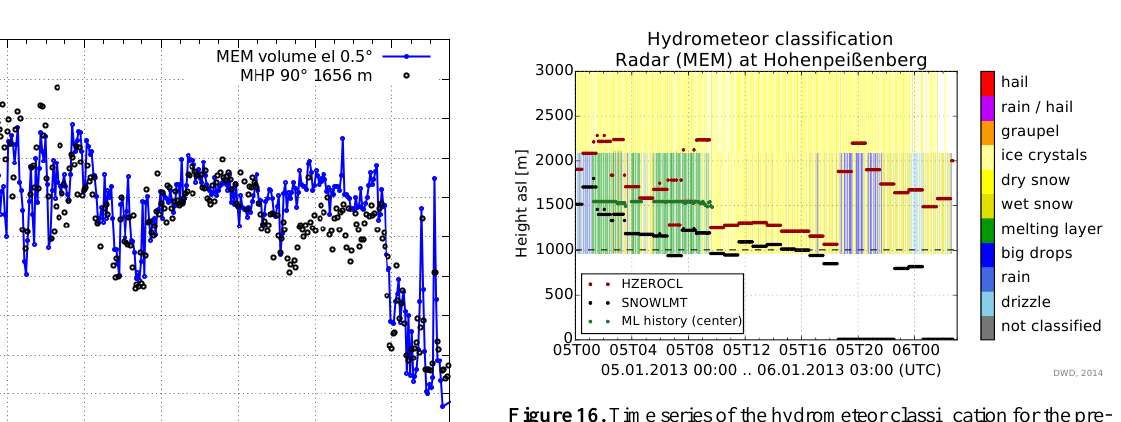
Figure 16. Time series of the hydrometeor classification for the pre- cipitation scan and the volume scan of radar MEM at the position of MHP. Overlaid is the 0 ◦ C level HZEROCL (brown), the snow- fall altitude SNOWLMT (black) and the center of the ML height (green). The considered time span ranges from 00:00UTC, 5 Jan- uary 2013, until 03:00UTC, 6 January 2013. The color table for the hydrometeor classes is the same as in Fig. 14.